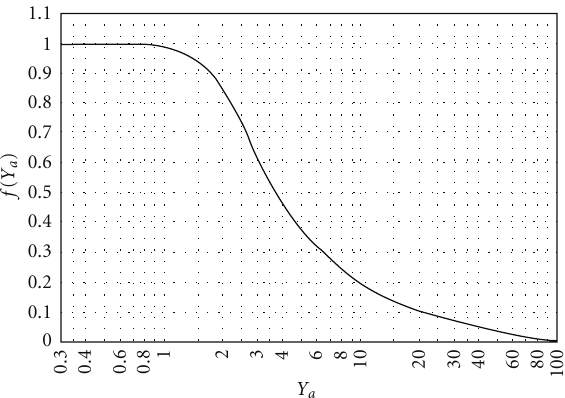
Figure 8: The streaming potential coe ffi cient measured as a func- tion of frequency by Sears and Groves [63] on a capillary coated with clay, incubated with BSA in 0.02 M